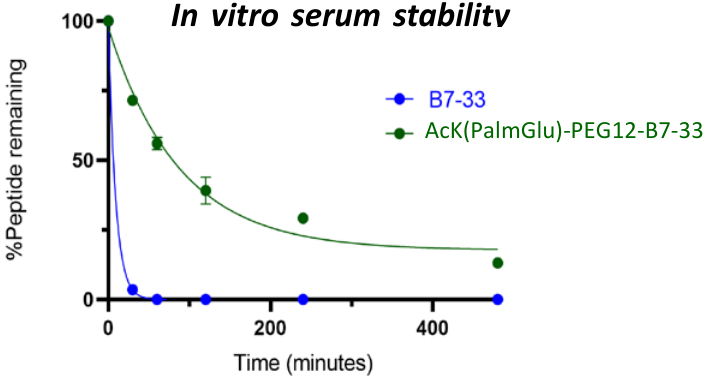
Figure 5. In vitro serum stability assay. B7-33 degrades within minutes, whereas AcK(PalmGlu)- PEG12-B7-33 is stable in serum over time. There were significant differences between the peptides at any time point ( p -value = 0.0222, t -test). One-phase exponential decay and paired t-test analyses were performed with GraphPad Prism 8.4.3. The data are the results of n = 3 independent experiments.